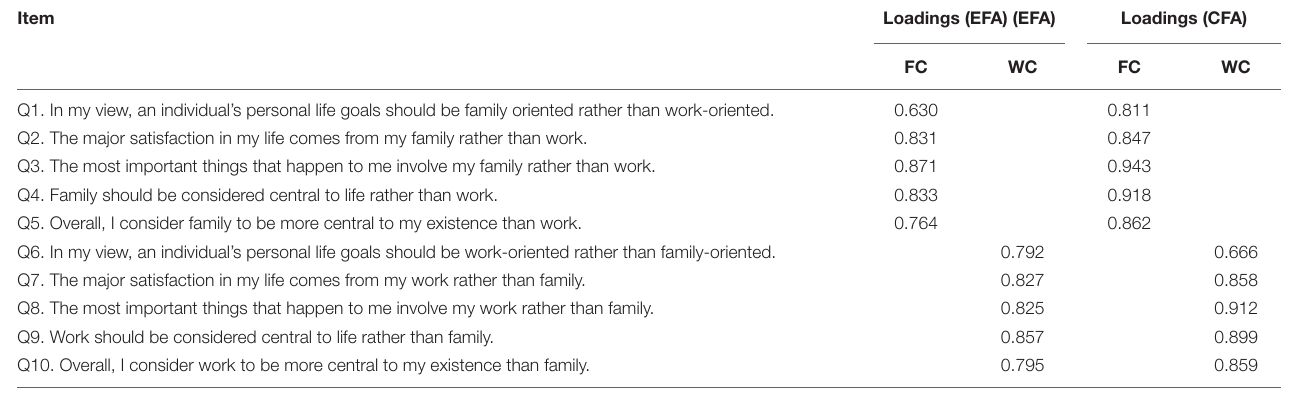
TABLE 3 | Results of the EFA and CFA (10 items).